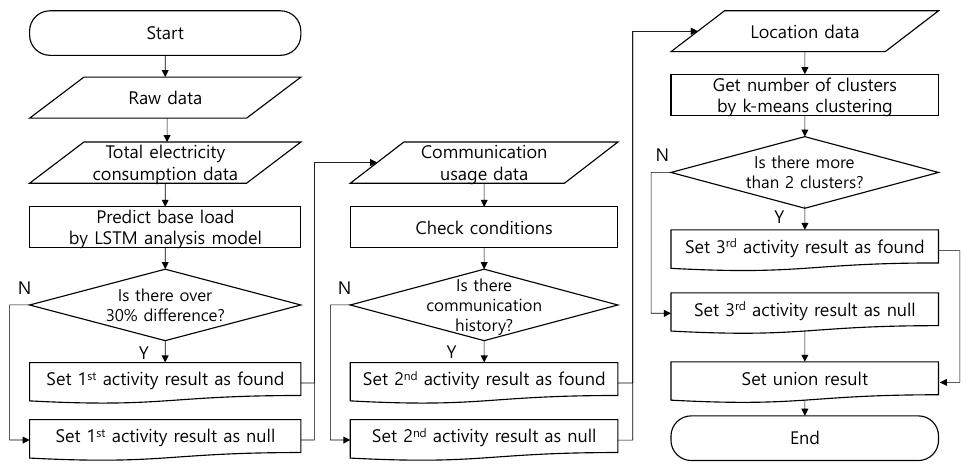
Figure 14. Flow chart of combined analysis.